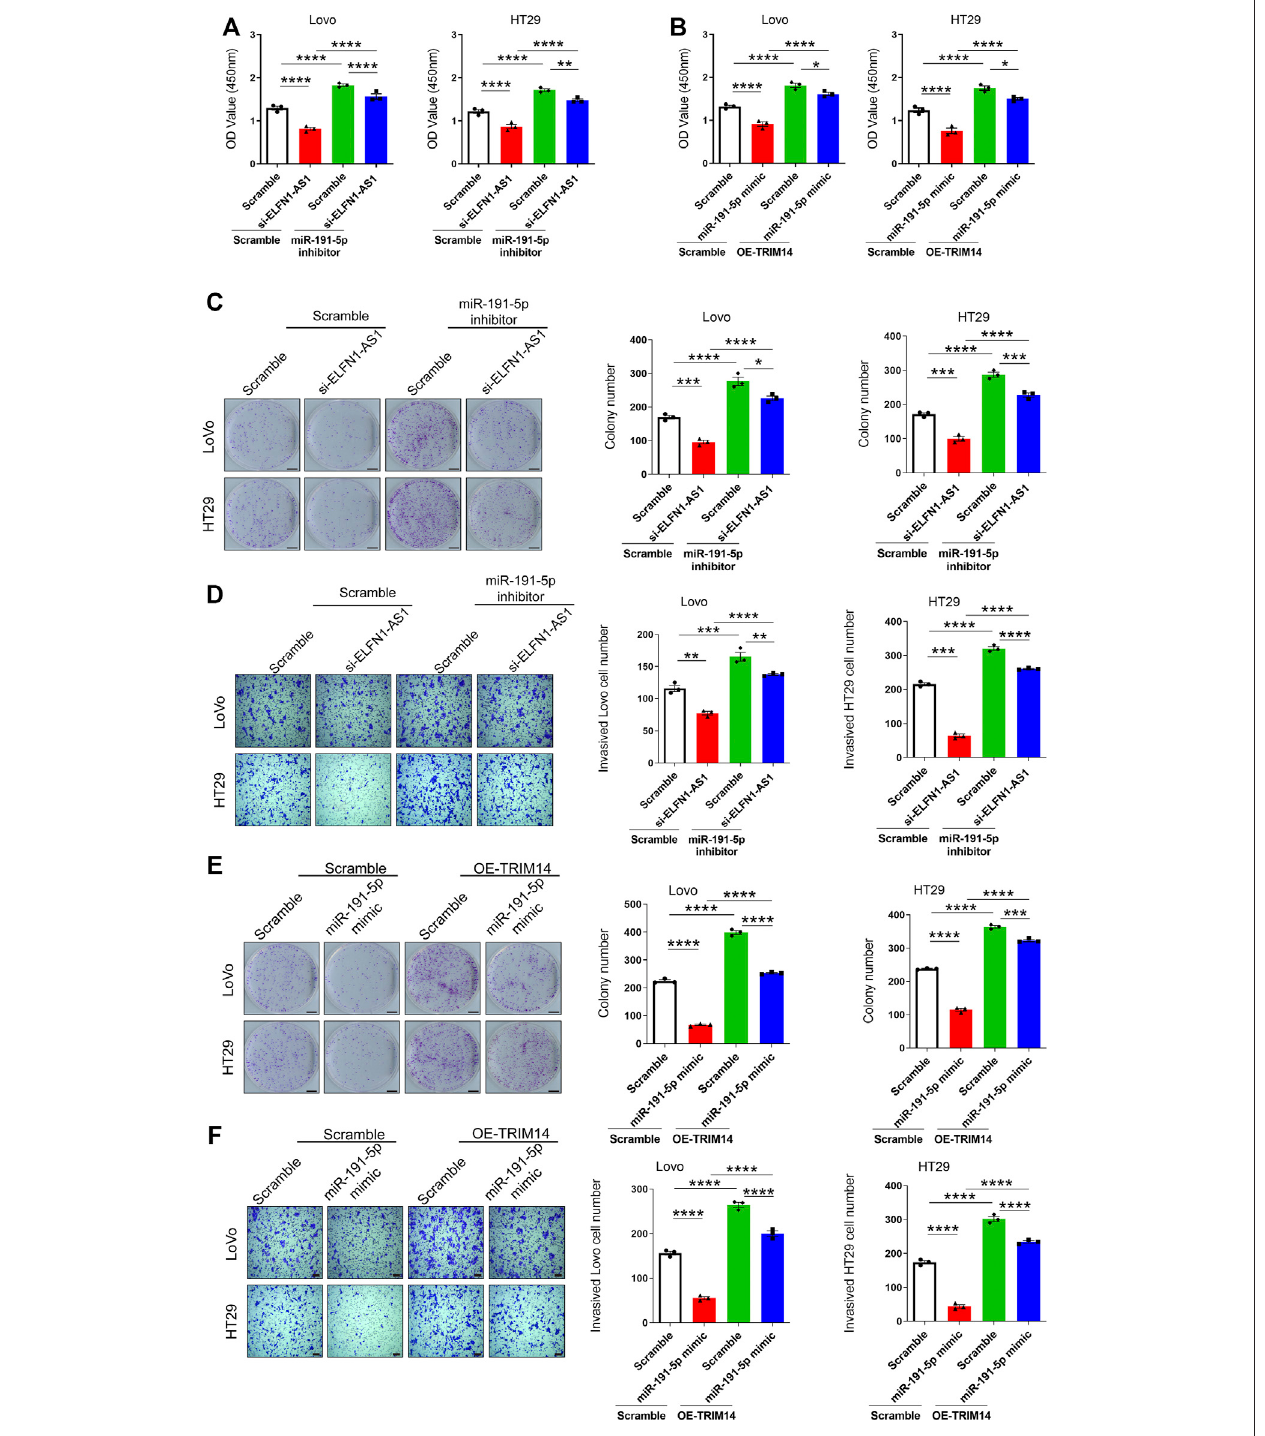
FIGURE 5 | Knockdown of ELFN1-AS1 inhibited the proliferation and invasion by regulating the expression of TRIM14 by targeting miR-191-5p. (A) and (B) Cell viability was detected using CCK8 assay. (C) Colony formation assay was performed to determine the proliferation of LoVo and HT29 cells. The photo of the plates was takenafter14 daysofincubation.Thecolonynumberofeachgroupwascountedin fi verandom fi elds.Scalebar5 mm. (D) Transwellassaywasperformedtodetectthe invasionofeachgroup.After24 hofcultureinmatrigelchambers,cellswerephotographedunderamicroscopeat×100magni fi cation.Thenumberofinvasivecells wascounted in three random fi elds. Scale bar 100 µ . (E) Colony formation assay was performed to determine the proliferation ofLoVo and HT29 cells. Scale bar 5 mm. (F) Transwell assay was performed to detect the invasion of each group. Scale bar 100 µ . One-way ANOVA was used for the comparison between the multiple groups with Bonferroni as a post hoc test. All data were representative of three independent experiments. * p < 0.05; ** p < 0.01; *** p < 0.001; **** p < 0.0001.